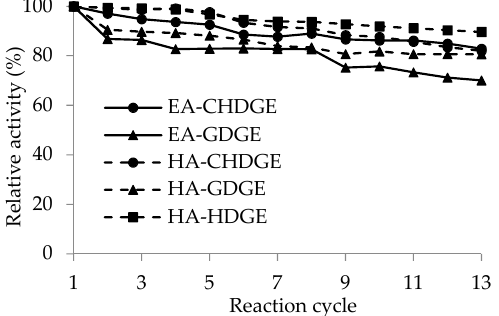
Figure 7. Continuous- flow kinetic resolution of racemic 1 -phenylethanol ( rac - 1 ) catalyzed by Ca LB preparations on bisepoxide-activated resins. Biocatalytic properties ( r flow , ee , E ) of immobilized Ca LB biocatalysts on ethylamine ( ) or hexylamine ( ) resin activated by CHDGE (●), GDGE ( ) or HDGE ( ), compared to EP Ca LB in ). ( a ) Effect of the substrate concentration on specific reaction rate ( r flow ); ( b ) Effect of temperature on specific reaction rate ( r flow ); ( c ) Effect of temperature on enantiomeric excess ( ee ); ( d ) Effect of temperature on enantiomeric ratio ( E ).